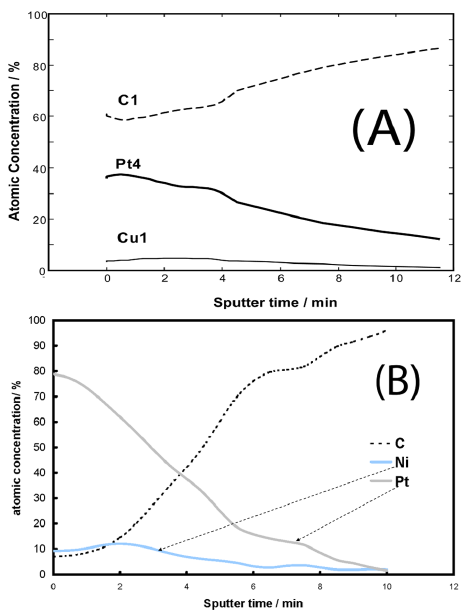
Figure 5. Sputter-etch Auger Electron Spectroscopy (AES) analysis of Pt-based bimetallic layers